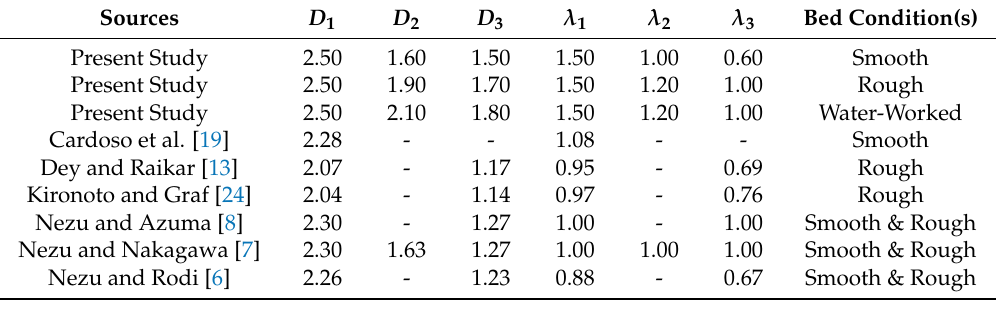
Table 2. Empirical constants from the present study and literature for turbulence intensity exponential law.